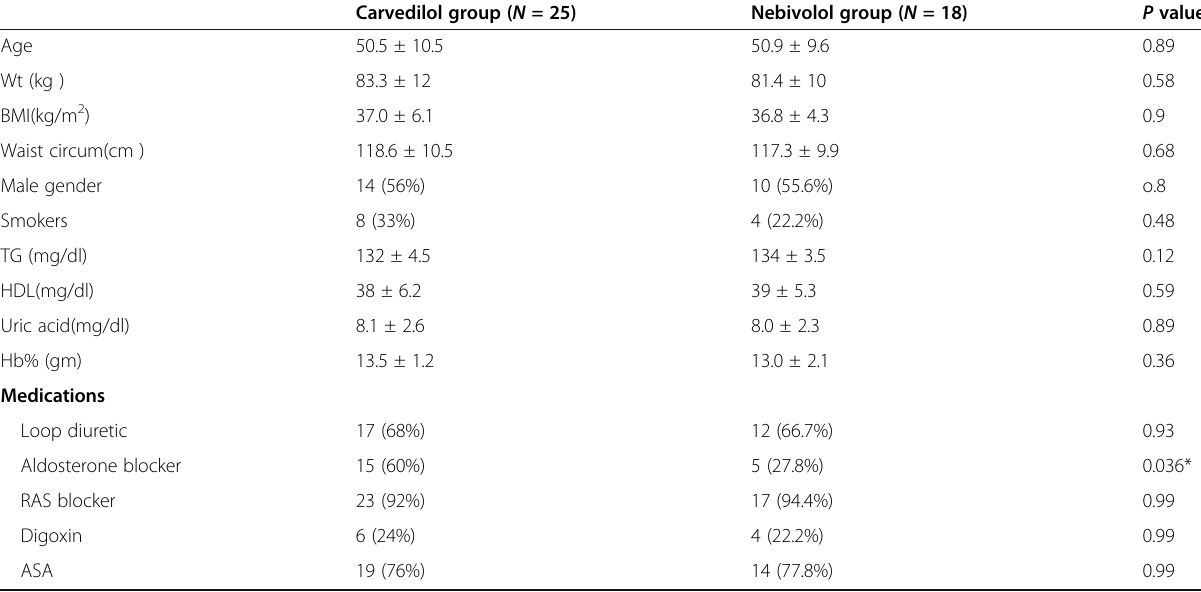
Table 1 Demographic, baseline clinical, and medications among the two